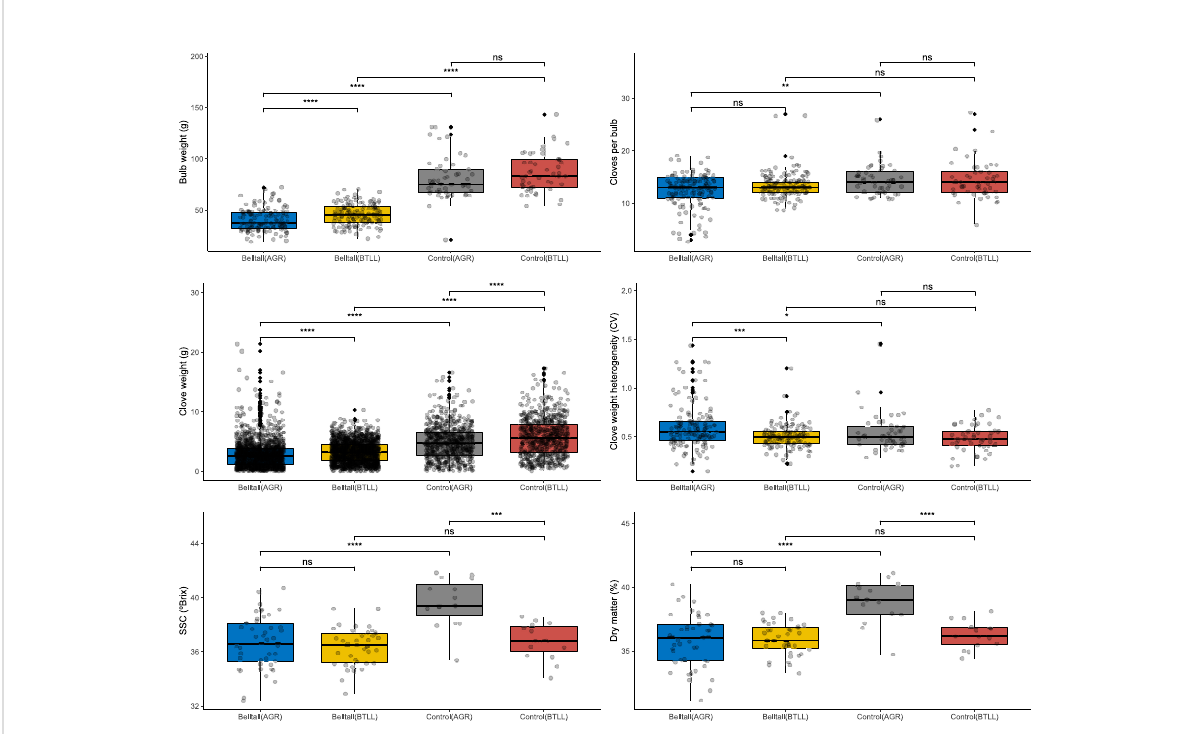
FIGURE 5 Analysis of quantitative traits of the Belltall landrace in comparison with the controls grown in their original Belltall locality (BTLL) and in a highly different pedoclimatic locality (Agropolis, AGR). Each dot represents a biological replicate. Belltall group includes B1-B11 and B14-B16 accessions, control group includes T1-T5 varieties. Pairwise comparisons between groups were calculated with the Wilcox test. ns (not signi fi cant): p > 0.05; *: p <= 0.05; **: p <= 0.01; ***: p <= 0.001; ****: p <=